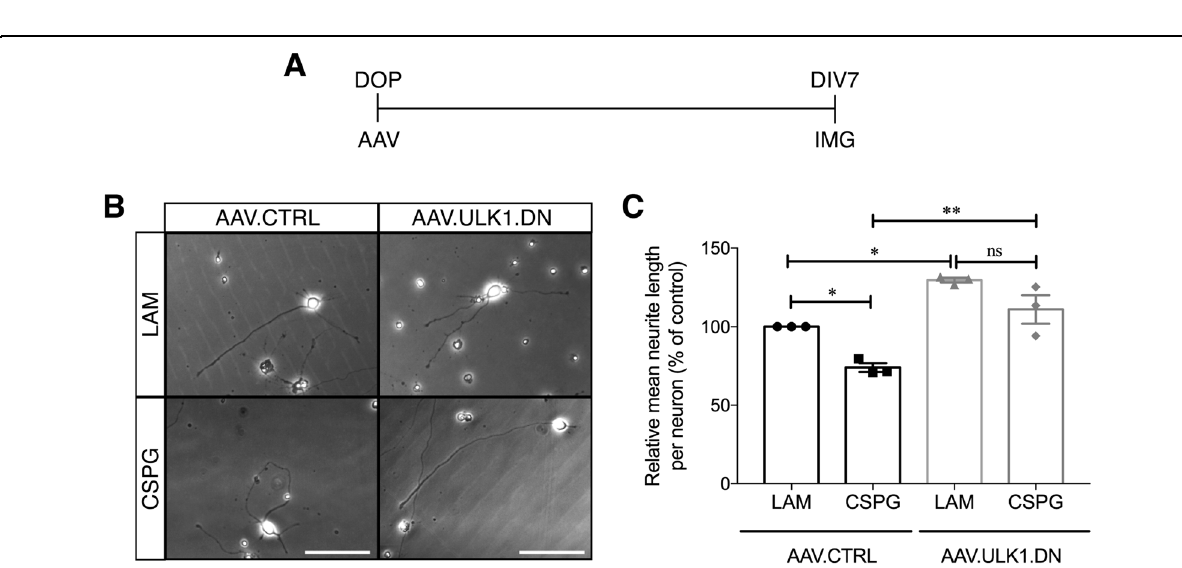
Fig. 2 AAV.ULK1.DN increases neurite outgrowth on permissive and non-permissive substrate. A Scheme of experimental setup for neurite outgrowth assays. DOP: day of preparation of E18 rat cortical neurons; DIV: day in vitro; AAV: transduction with adeno-associated viral vectors; IMG: imaging. B Representative images of cortical neurons cultured on permissive (laminin - LAM) and non-permissive substrate (CSPG) and transduced with viral vectors. Scale bar: 100 µm. C Quanti fi cation of the relative mean neurite length per cell after transduction with AAV.CTRL and AAV.ULK1.DN ( n = 3 independent cultures). Data are presented as single data points and means ± SEM; ns = no signi fi cant difference, * P < 0.05, ** P < 0.01, according to one-way ANOVA and Tukey ’ s multiple comparisons